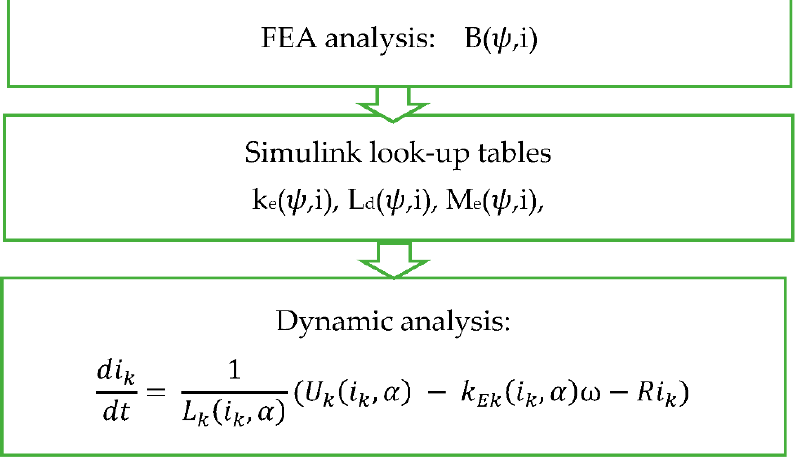
Figure 11. Flux mesh graph of one phase at different current and angle values.